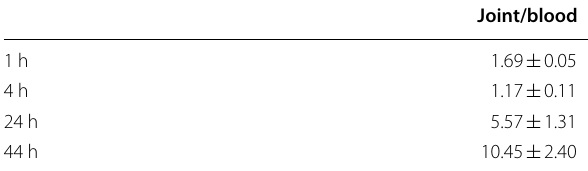
Table 1 Joint-to-blood ratios of [ 64 Cu]Cu-NOTA-CD4 uptake in joints of collagen-induced arthritis mice with high arthritis score (score 3) ( n 13/time point). Ratios are presented as mean =